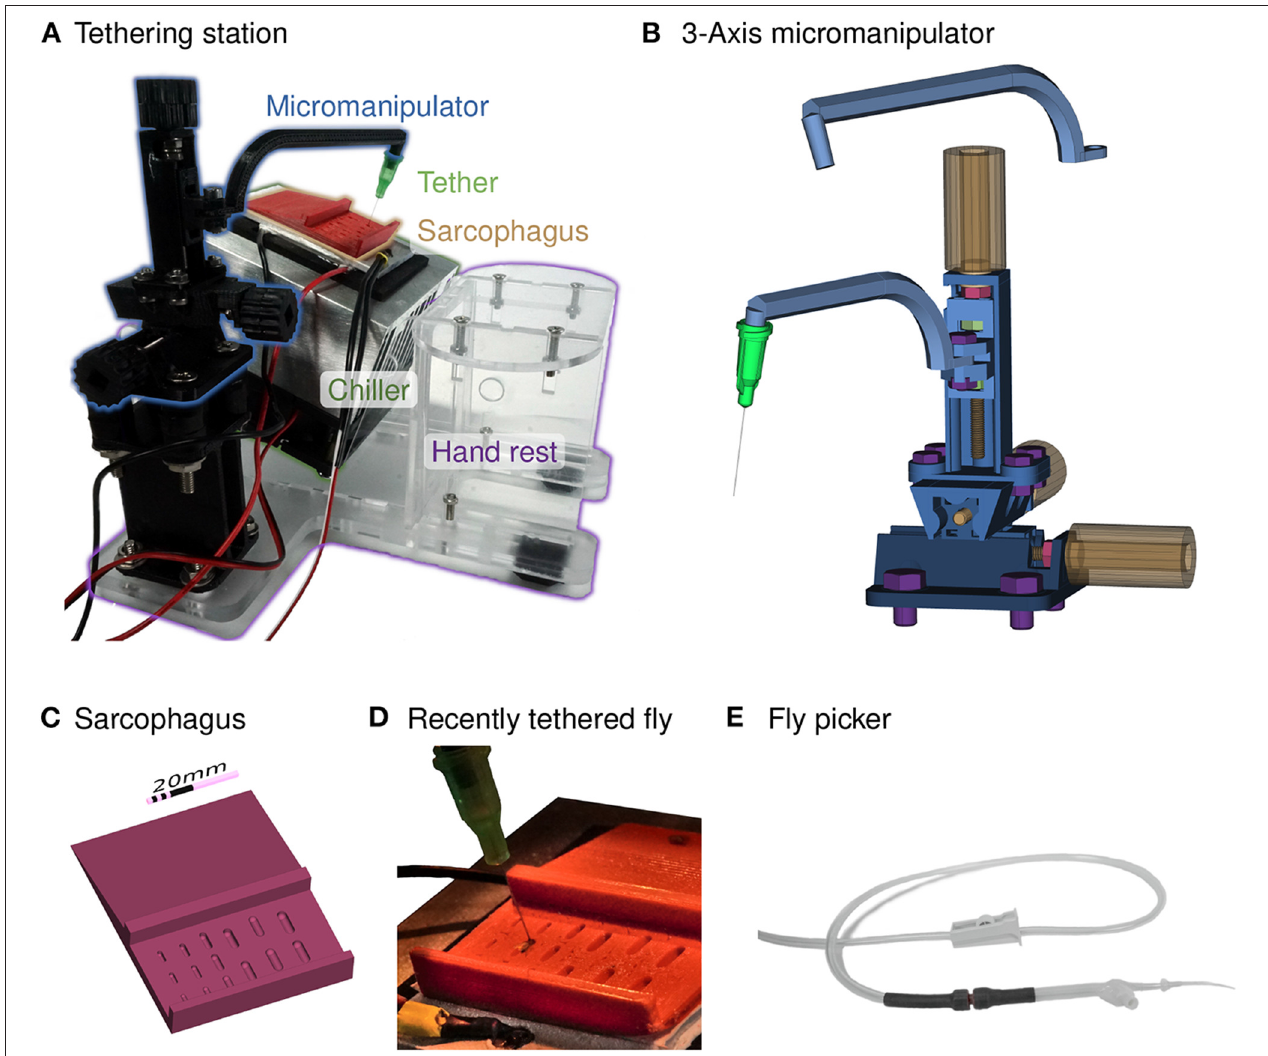
FIGURE 2 | Chilled tethering station for preparing flies. (A) Photograph highlighting the major components of the tethering station: micromanipulator (in black), sarcophagus (in red), Peltier-based chiller with heat-sink (silver and black), and a transparent laser-cut fixture with a hand rest. This setup is typically positioned under a dissecting microscope, and a thermistor is used to measure the top surface of the chiller for closed-loop temperature control. (B) A compact, 3-axis micromanipulator fabricated from 3D-printed parts and simple hardware components. Two different arms are shown, one for the tethering station and the other for the experimental rig. Each axis consists of a rotating handle and screw (in yellow), a locking nut (in red) that fixes the location of the screw relative to the outer rail, and nuts within each carriage (in green), that transfer the linear motion. The device is held together and mounted using additional screws (in purple). (C) A rendering of the sorting and mounting plate, containing a series of indentation, each referred to as a sarcophagus , of different dimensions for different animal sizes. Cold-immobilized flies are sorted on the top section of the plate, and single flies are positioned in one of the cavities for gluing to the tether. (D) A photograph of the plate mounted on top of the chiller with a temperature sensor (yellow tape) and a fly glued to the tether (a dispensing needle). (E) The fly picker used to move anesthetized flies. The picker uses suction controlled by the operator’s finger to pick up and deposit single